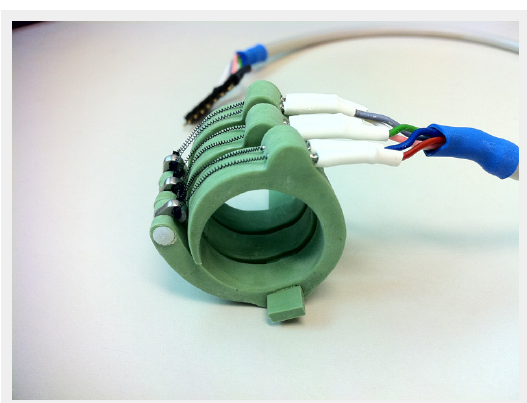
Illustration of a left eyelid sling that is attached to the electroactive polymer artificial muscle device (EPA) after passing through an interpolation unit is implanted in the lateral orbital wall (note screw fixation). The power supply and artificial muscle are implanted in the temporal fossa. Conceptually, when the normal right eyelid blinks, the electrical sensor (green) sends a signal to the battery to activate the